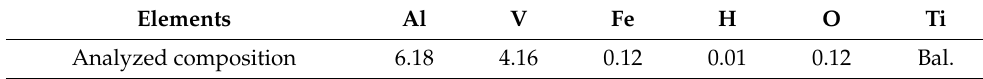
Table 1. Chemical compositions of the Ti-6Al-4V alloy (in wt.%). Elements Al V Fe Ti Analyzed